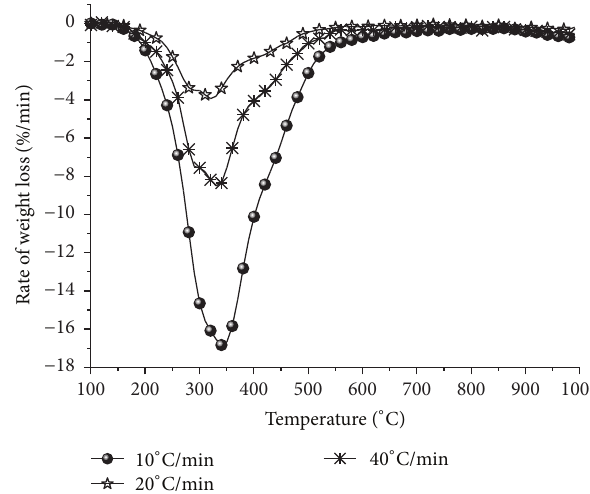
Figure 3: DTG curves of Chlorella vulgaris decomposition at the heating rates of 10, 20, and 40 ∘ Cmin −1 in N 2 atmosphere.